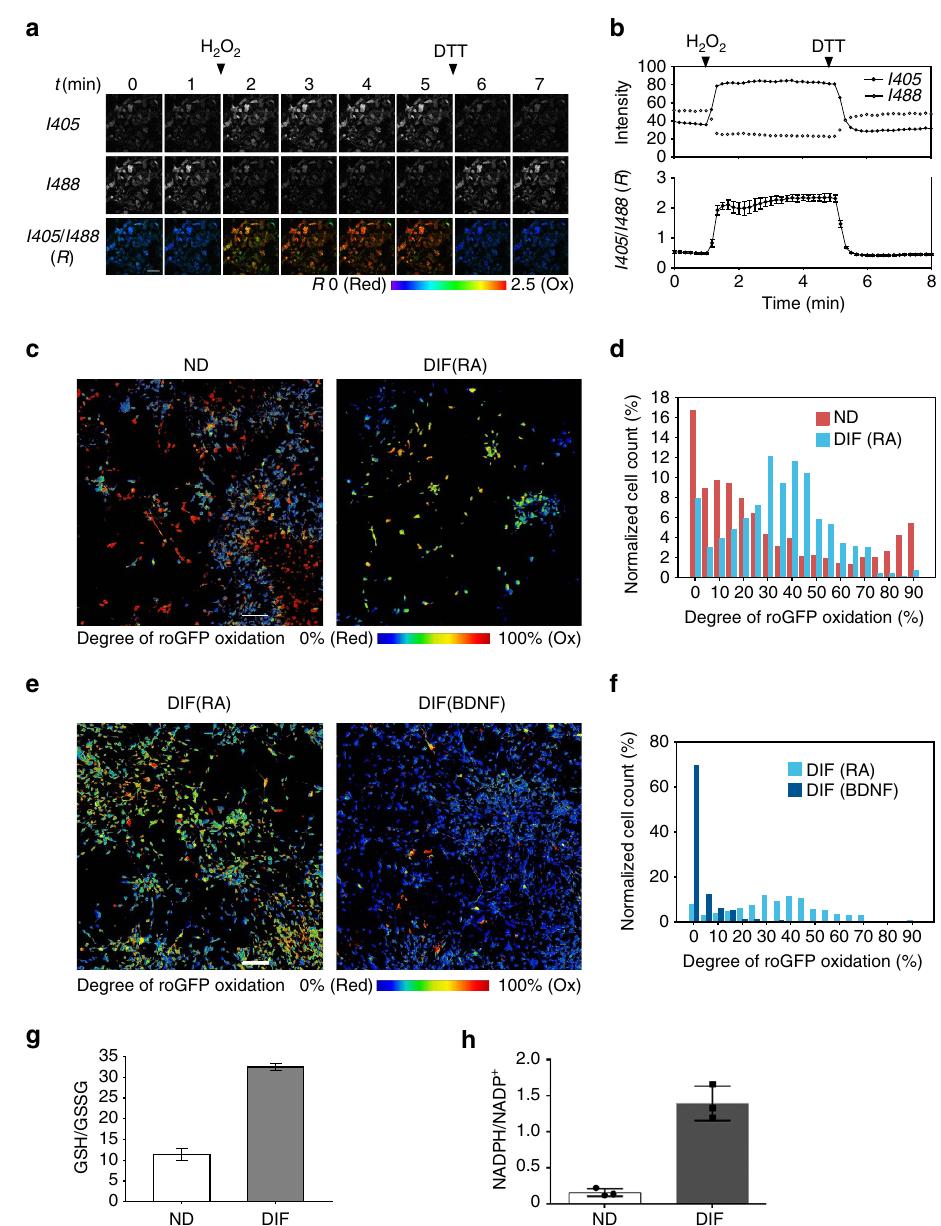
Figure 4 | Cytosolic glutathione homoeostasis in SH-SY5Ycells changes during cell differentiation. ( a ) Grx1-roGFP2 was expressed in differentiated SH- SY5Y cells using adenovirus and its sensitivity to redox changes was examined. Cells were sequentially treated with 500 m M H 2 O 2 and 2mM DTT. Time-lapse images with 1min interval are shown. Scale bars, 50 m m. ( b ) Top: changes in fluorescence intensity after illumination at I488 and I405 are plotted for one representative cell. Bottom: plot of average R value for 15 cells. ( c , e ) The analysis of cell population demonstrated large variation in redox states of non-differentiated SH-SY5Ycells and a significant change upon RA and BDNF treatments. ( d , f ) Histograms for images shown in c , e . To increase the sample size, another 1,125 m m (cid:3) 1,125 m m area was scanned and analysed together (Supplementary Figs 12–14). n ¼ 1,079 cells (ND), 633 cells (RA) and 1,584 cells (BDNF). Scale bar, 200 m m. ( g ) Neuronal differentiation is associated with increase of GSH/GSSG ratio. The amounts of GSH and GSSG were measured spectrophotometrically using enzymatic assay; mean values are 11.4 and 32.5 for non-differentiated and differentiated cells, respectively ( n ¼ 3). Each value is presented as mean ± s.d. ( h ) The NADPH/NADP þ ratio increases 8.6-fold from 0.16 ± 0.03 in non-differentiated SH-SY5Y cells to 1.40 ± 0.14 in differentiated cells ( n ¼ 3; Student’s t -test, P o 0.001). Squares and circles indicate each data point and bars represent s.d. The change in NADPH/NADP þ ratio is due to a decrease in NADP þ and an increase in NADPH levels (Supplementary Fig.